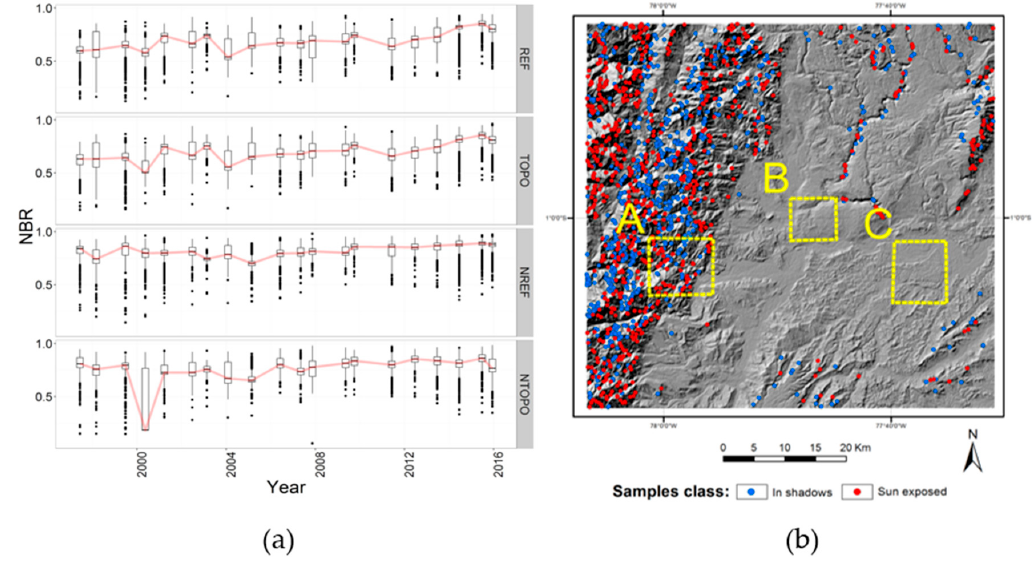
Figure 4. ( a ) Examples of different pre-processing approaches using yearly mosaics and the NBR vegetation index. Boxplots were based in samples located at sun-exposed and shadow areas. Red lines highlight mean values in the time-series. The acronyms on the right stand for: REF or surface reflectance; TOPO or topographic correction; NREF or radiometric normalization of surface reflectance; and NTOPO or radiometric normalization of topographic correction. ( b ) Map of the samples used in boxplots. Blue dots identify shade-exposed samples while red dots identify sun-exposed samples.